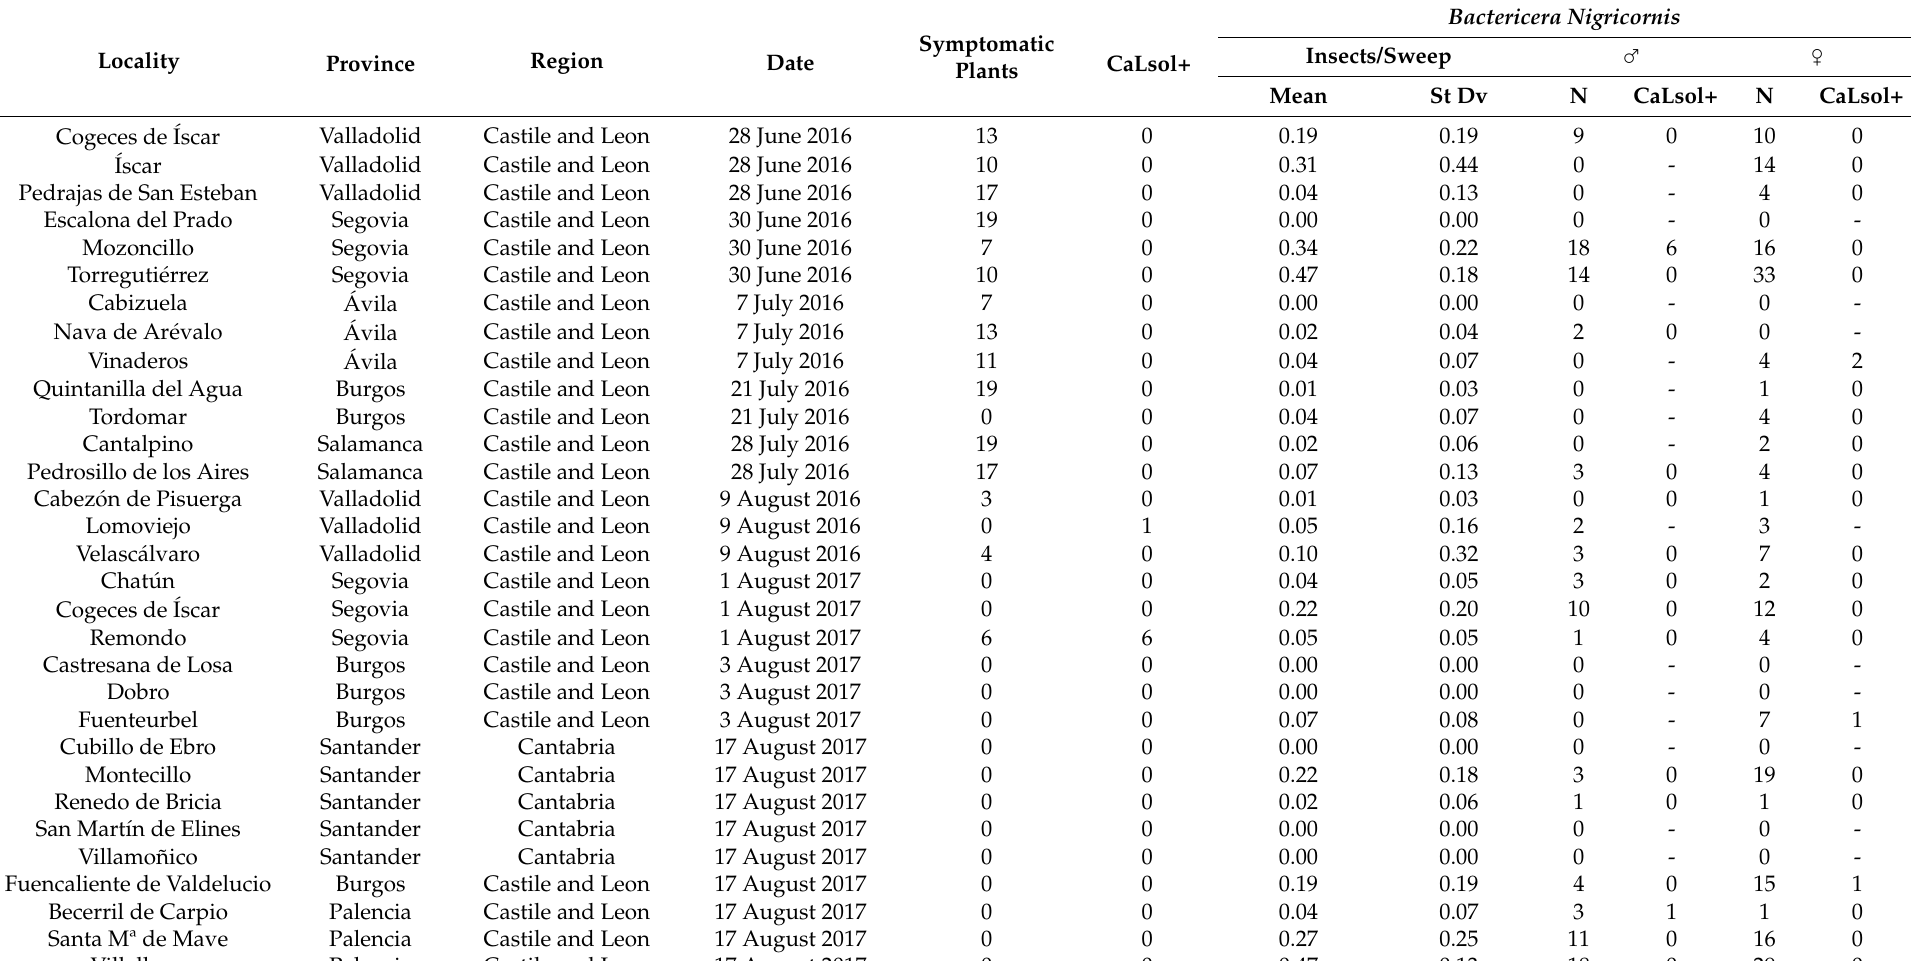
Table 1. Symptomatic and positive plants for Candidatus Liberibacter solanacearum (CaLsol); mean and number of males and females and percentage of CaLsol+ specimens of Bactericera nigricornis captured by sweep net, in occasional surveys in potato fields, in different production areas, in 2016, 2017, and